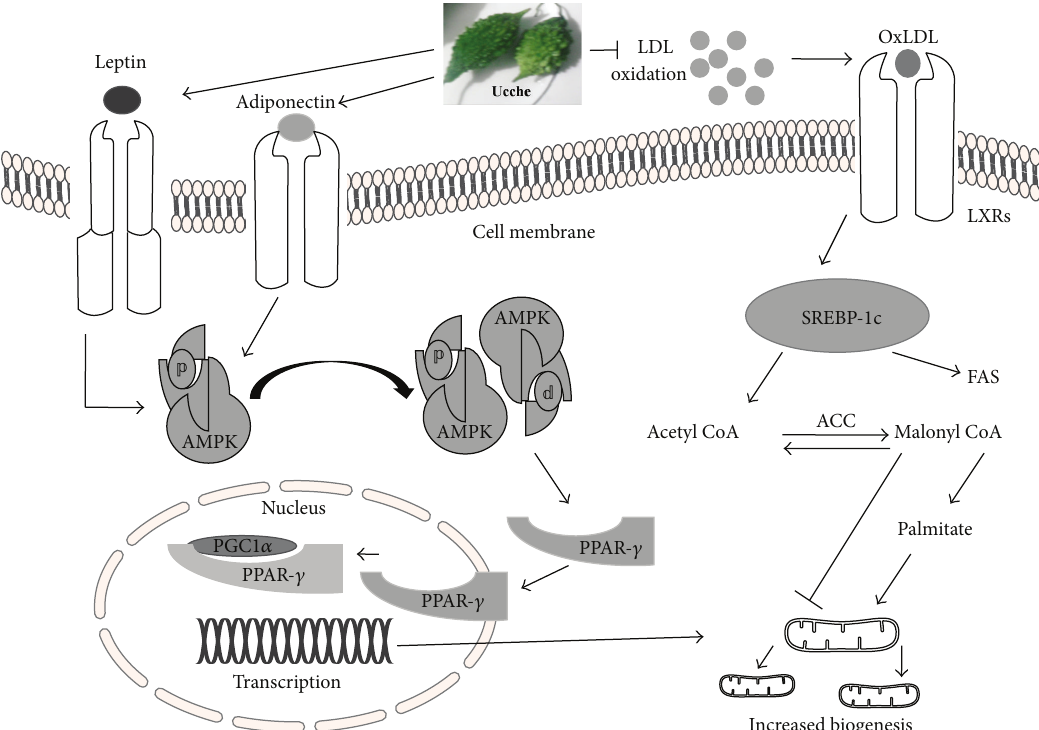
Figure 6: Hypothetical mechanism of bitter melon on fat metabolism in liver tissue via AMPK-PPAR 𝛾 mediated pathways.